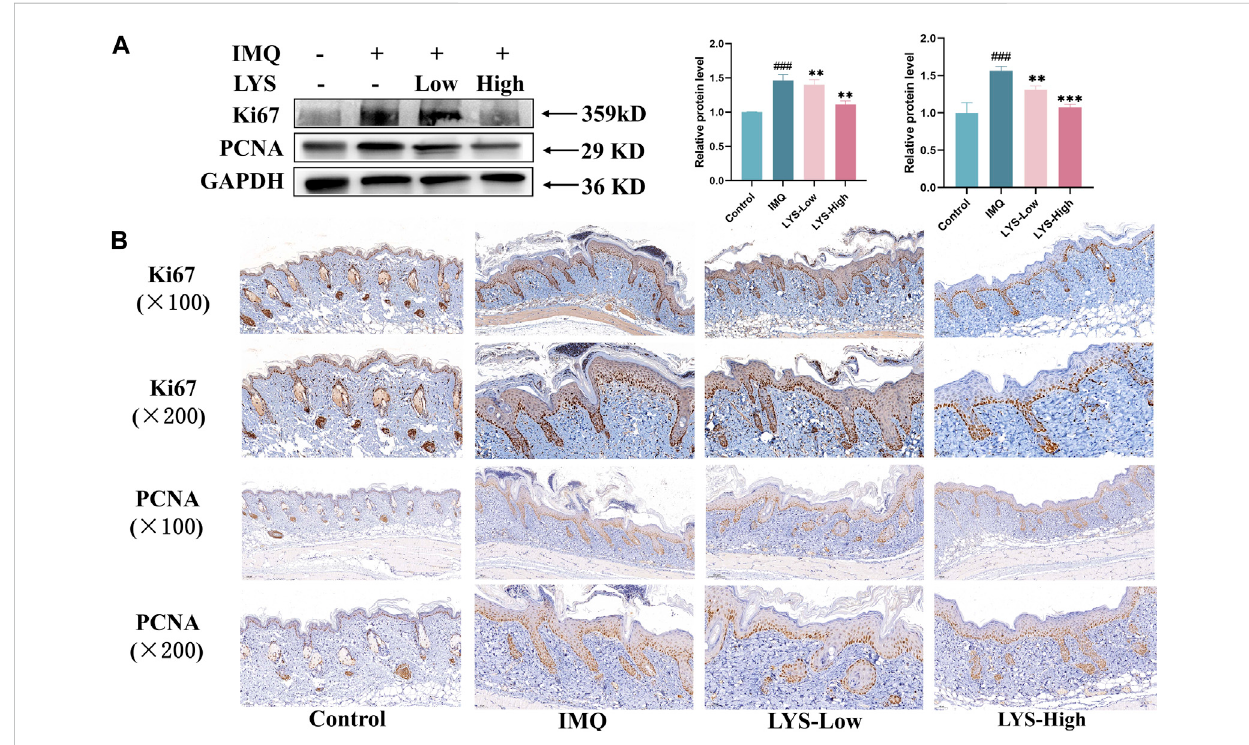
FIGURE 5 LYSdecreasedKi67andPCNAproteinexpression,asevidentinWB (A) andIHCstaininganalyses (B) .Thedataareexpressedasthemean±SD( n =3). ### p < 0.001 vs. the control group; ** p < 0.01, and *** p < 0.001 vs. the IMQ group.